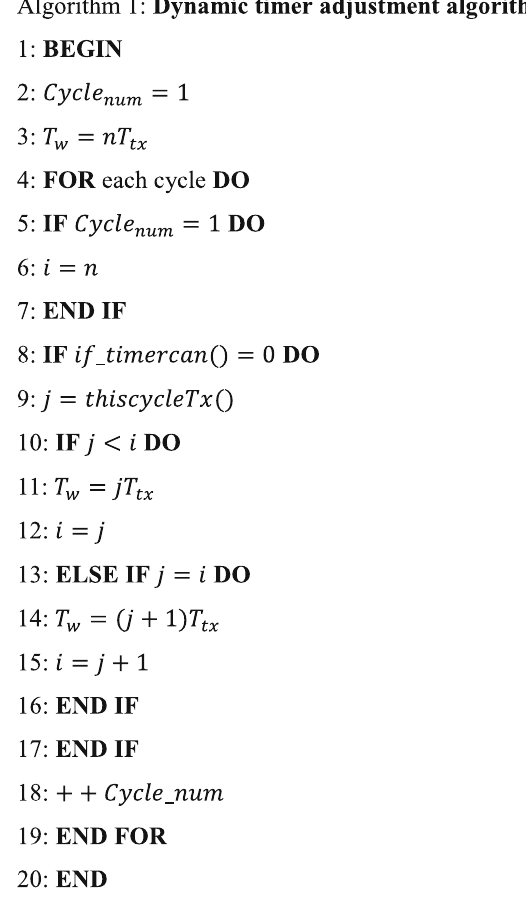
A case in which the initial wait time is short is ana- lyzed first, setting the initial value of T The transmission process of this initial wait time is shown in Fig.